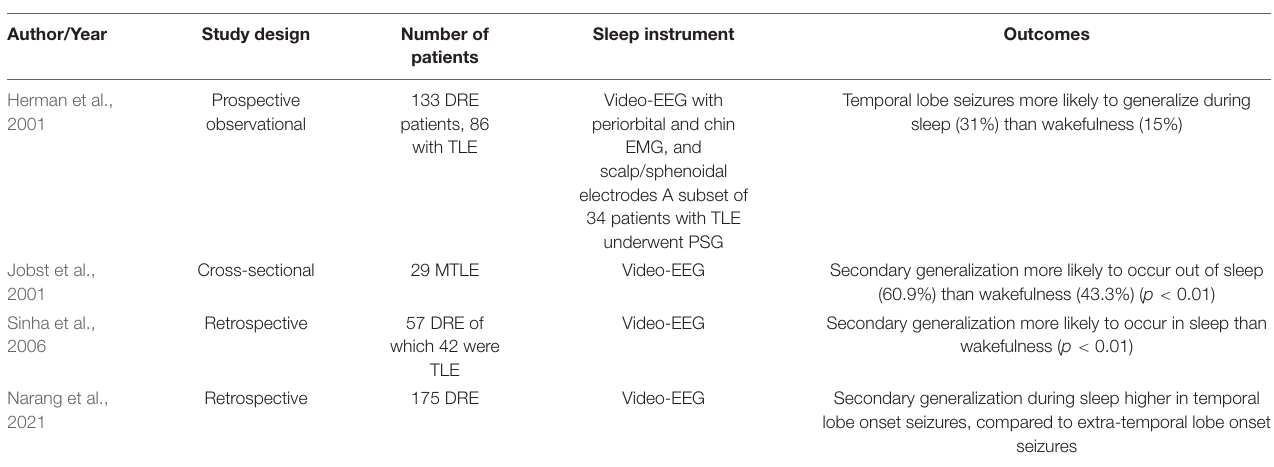
TABLE 2 | Studies assessing secondary generalization of TLE in